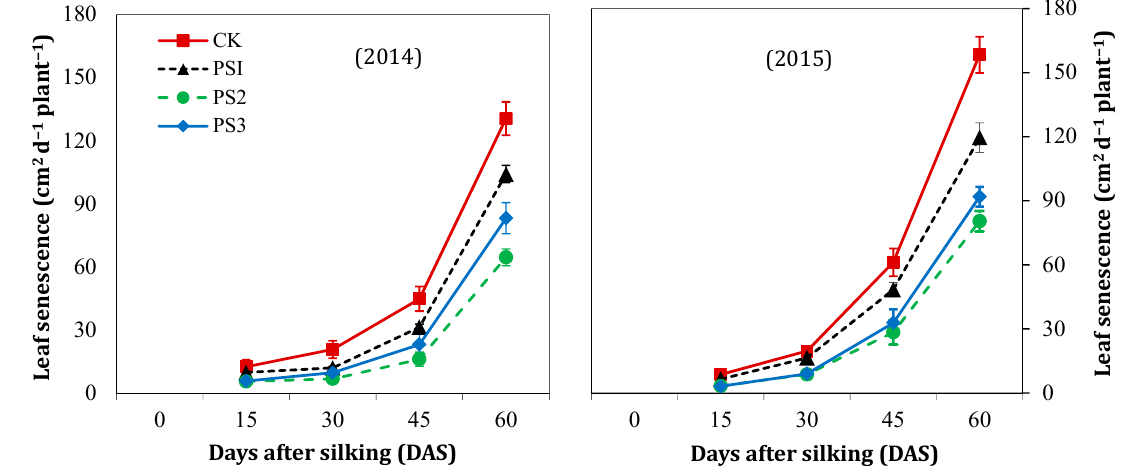
Figure 2. Effects of paclobutrazol treatments on the leaf senescence rate in maize during 2014 and 2015. Data are presented as mean ± SD of three measurements. CK, PS1, PS2, and PS3 represent seed treatment with paclobutrazol at the rate of 0, 200, 300, and 400 mg L − 1 , respectively.